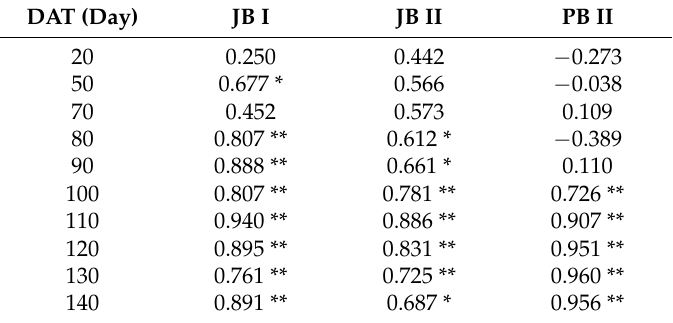
Table 1. Pearson correlation analysis of the NDVI measurements and yield of JB cultivar in year I and II and PB cultivar in year II.